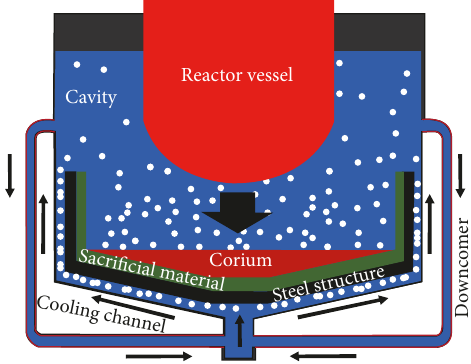
Figure 1: Schematic diagram of a core